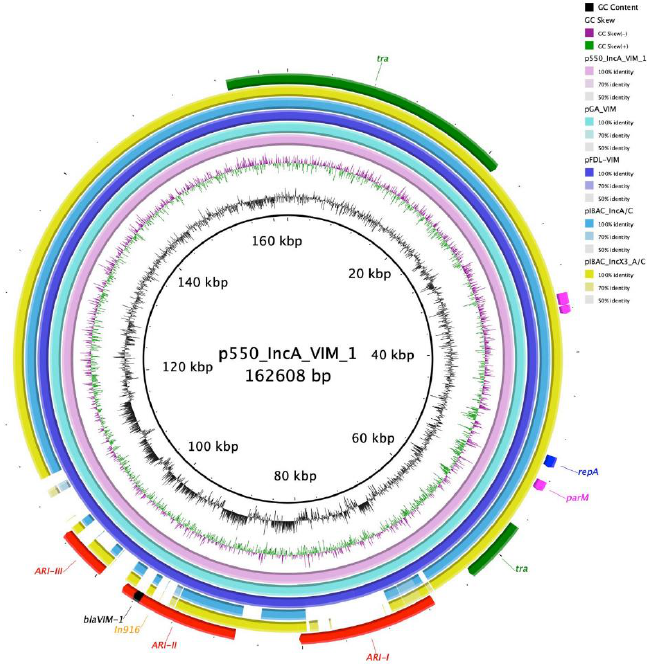
Figure 1. Circular map of p550_IncA_VIM_1 against pGA_VIM (pink), pFDL-VIM (turquoise), pIBAC_IncA / C (violet), and pIBAC_Incx3_A / C (yellow). At the outer curved segments; red, yellow, black, green, purple and blue corresponds to ARIs, In 916 , bla VIM-1 , tra region, maintenance and stability region, and repA